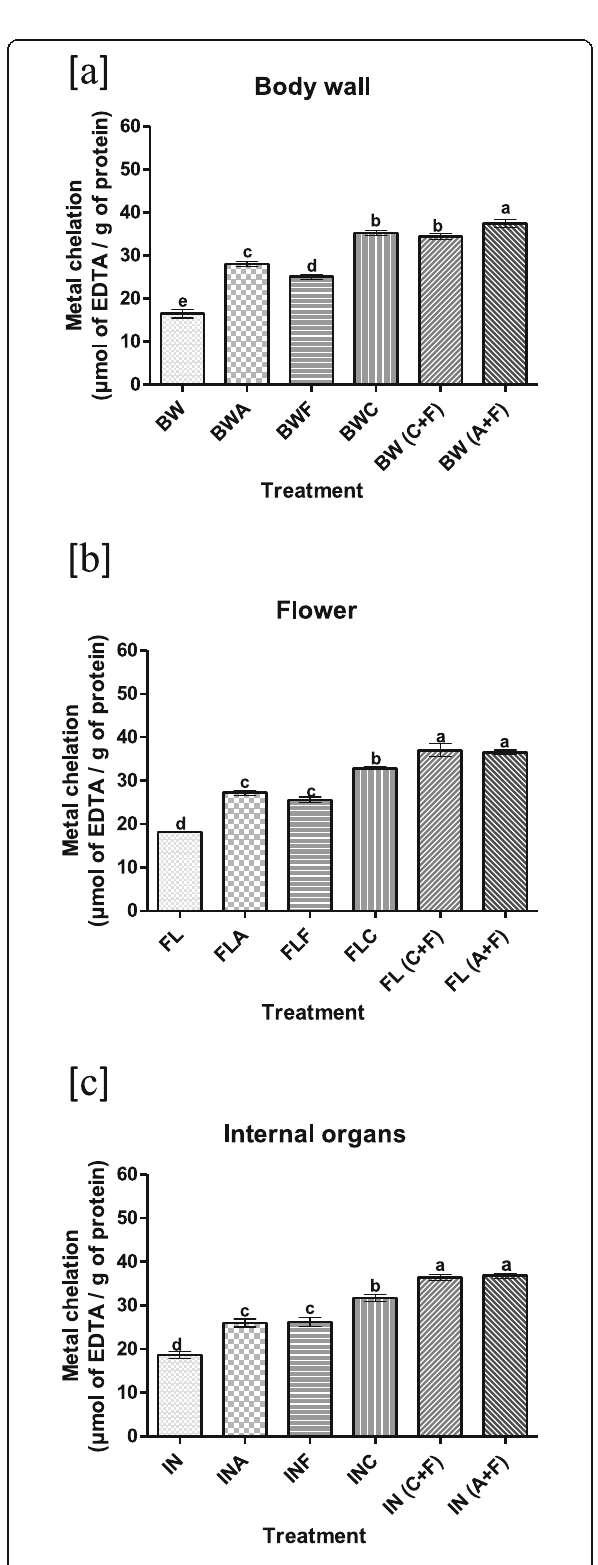
Fig. 6 Metal chelation ability of protein hydrolysates of sea cucumber C. frondosa protein hydrolysates a BW, Body wall; b FL, Flower; and c IN, Internal organs; A, Alcalase; F, Flavourzyme; C, Corolase; C+F, Mixture of Corolase and Flavourzyme; and A+F, Mixture of Alcalase and Flavourzyme. Different letters for the same concentration of all hydrolysates indicates significant difference at p